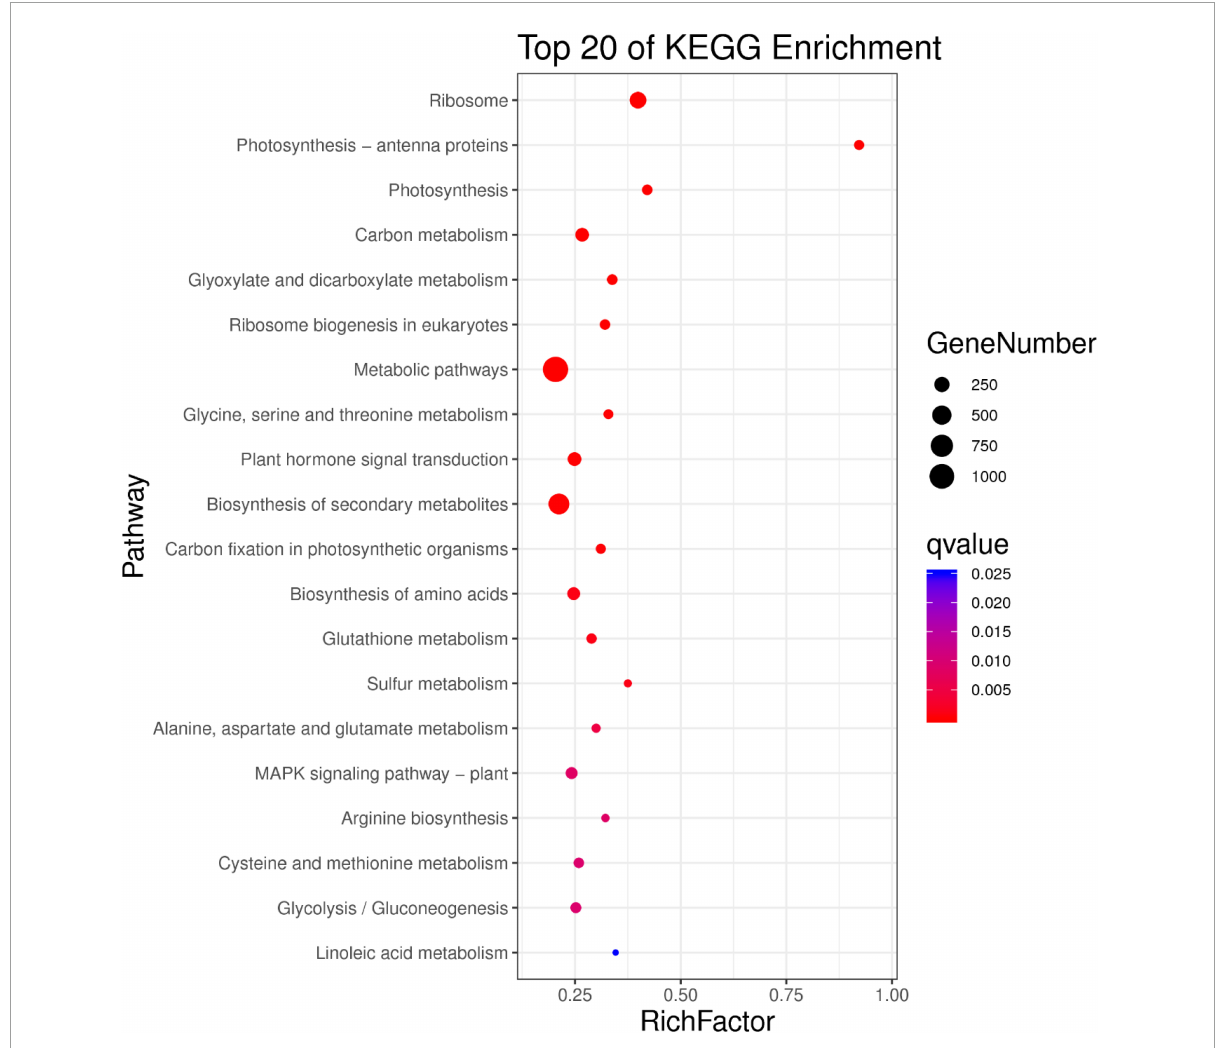
FIGURE8 Kyoto Encyclopedia of Genes and Genomes (KEGG) pathway enrichment analysis of DEGs between WT and OE5. The X -axis represents the enrichment factor, and the Y -axis represents the enrichment gene. The size of the dot represents the number of differentially enriched